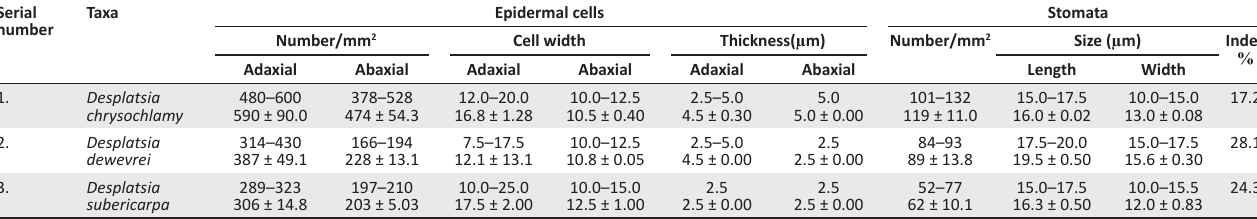
TABLE 3: Quantitative epidermal and stomata characters of some Desplatsia species in West Africa.